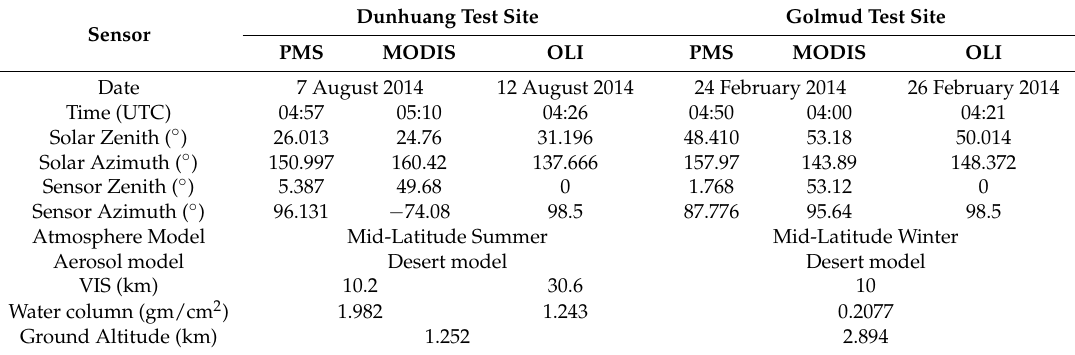
Table 2. Input parameters of MODTRAN for spectral band adjustment factors (SBAF) calculation.